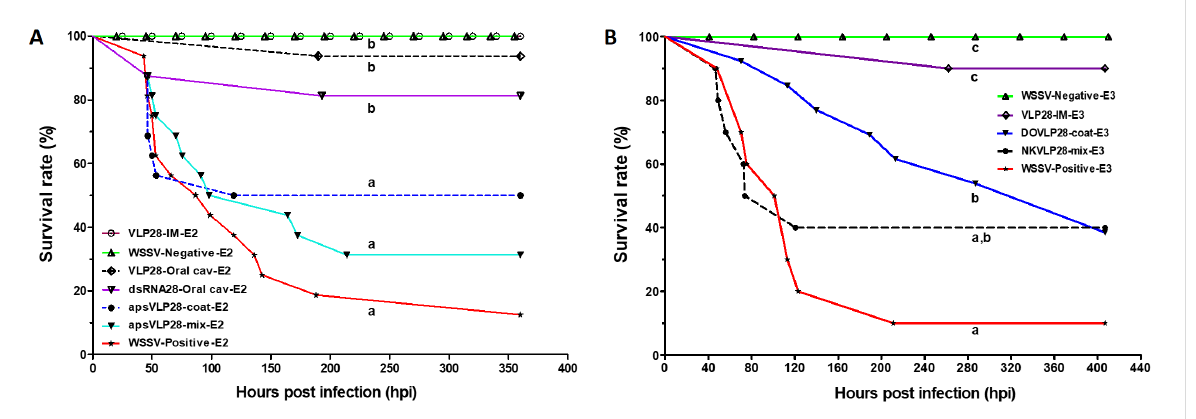
Figure 4: Cumulative survival curves of P. vannamei infected with WSSV and provided with VLPs antiviral treatment. (A) Pellets with VLP- dsRNAvp28 and covered with salmon oil (apsVLP28-coat or mixed). Administration by oral cavity (VLP28-oral cav-E2, and dsRNA28-oral cav-E2) means that the antiviral was given with a syringe right into the oral cavity. Note that these groups had high survival (93.75% and 81.25%) up to 350 hpi or 15 days. (B) Pellets with VLP-dsRNAvp28 prepared with commercial binders (Dry Oil ® and NutriKelp ® ). The bioassay was ended 17 days post- treatment (or 400 hpi). Different letters (a–c) on the curves indicate significant differences ( p < 0.0001) between treatments with Log-rank (Mantel–Cox), not the final absolute survival percentage. IM, intramuscular injection, see Table ST4 in Supporting Information File 1 for treatment abbreviature